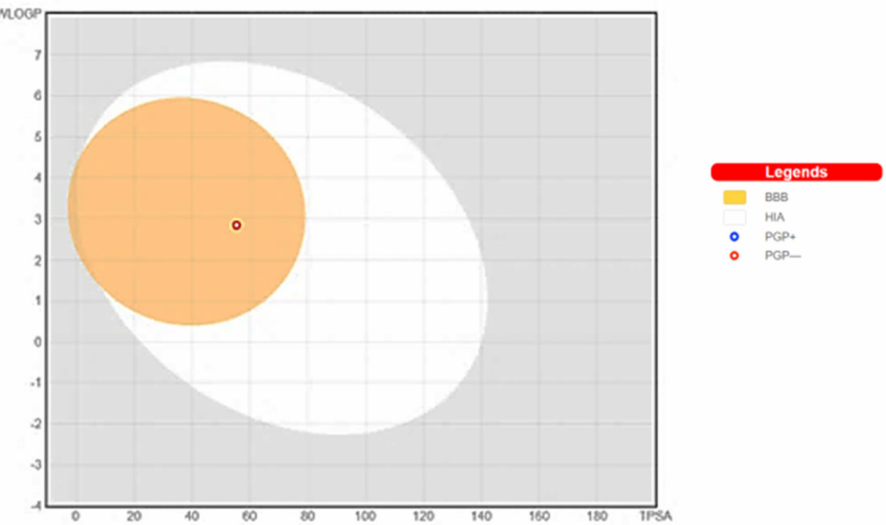
Figure 10. BOILED-Egg representation of ABQ-3 from SwissADME (Swiss Institute of Bioinformatics, Lausanne,